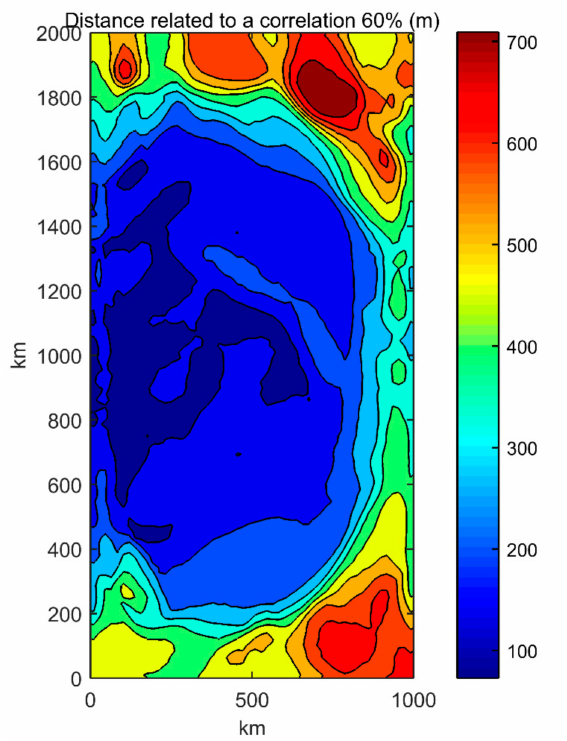
Figure 4. Map of the correlation distances (km) related to a correlation threshold of